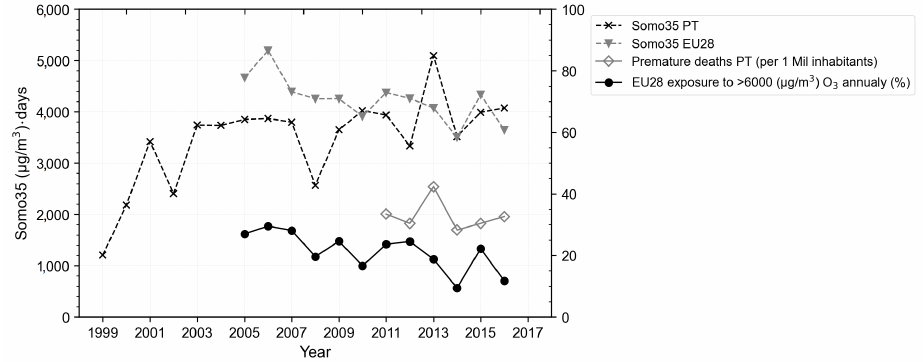
Figure 3. SOMO35 indicator for Europe and exposure to concentrations higher than 6,000 (µg/m 3 ) · days; Portuguese evolution and estimated deaths by ground-level O 3 [35].